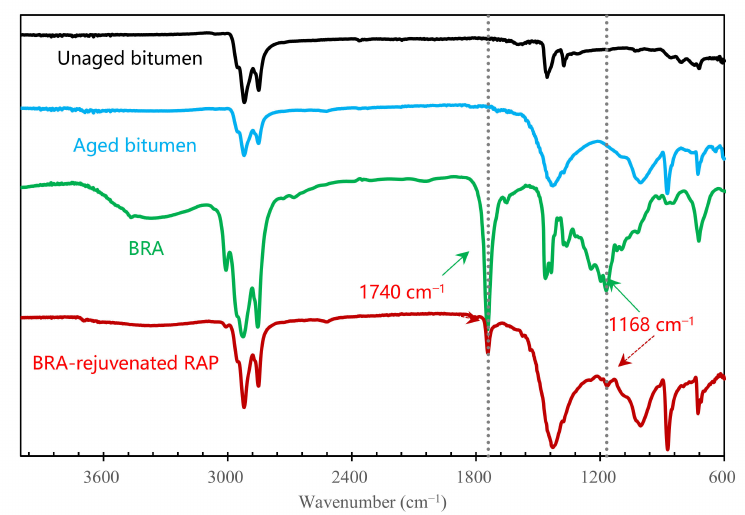
Figure 3. FTIR spectra of BRA and bituminous